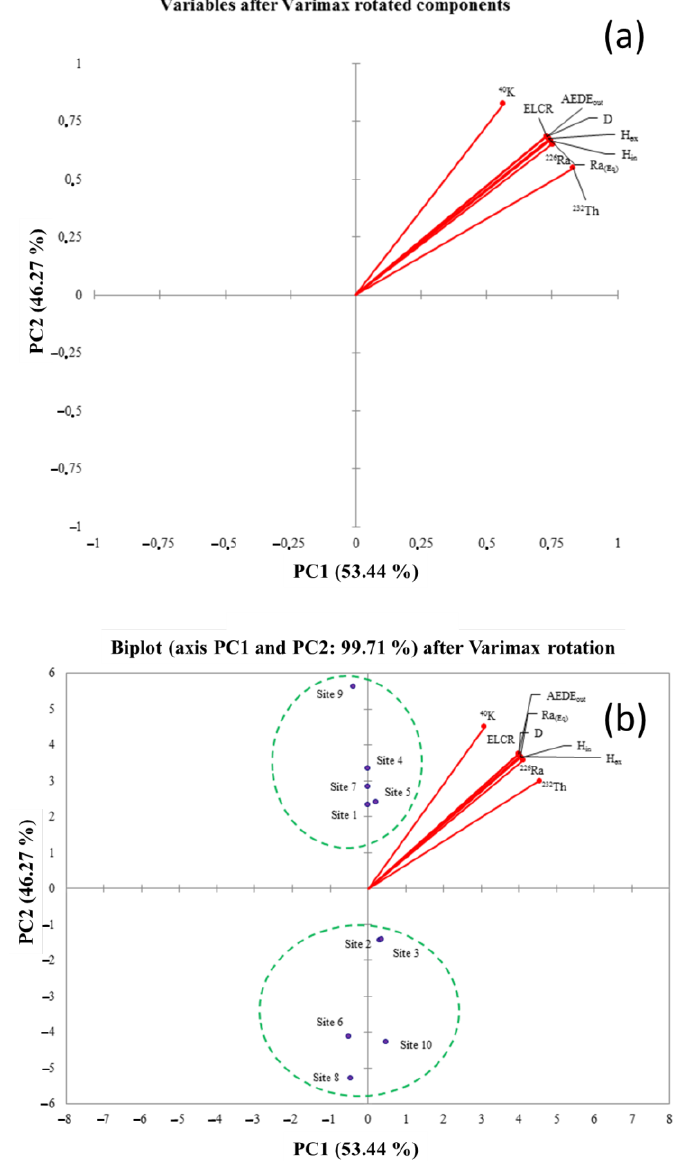
Figure 4. PCA loading plot of the nine original variables ( a ). PCA loading plot with the insert of pyroclastic product sampling sites ( b ).